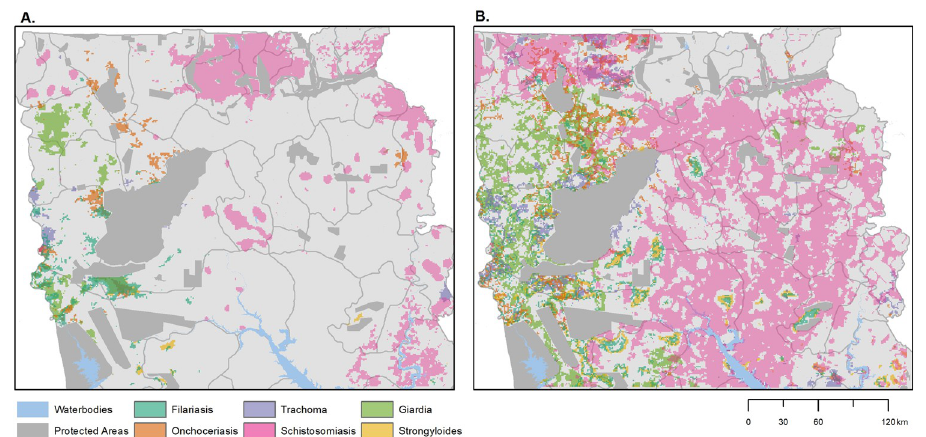
Fig 3. Combining disease measures to A) identify regions with high probabilities of exceeding 10% seroprevalence (exceedance probabilities > 70%); and B) identify regions with high uncertainty (exceedance probabilities 40–60%); administrative shapefiles obtained from National Information Technology Agency (NITA), Government of Ghana (https://data.gov.gh/dataset/shapefiles-all-districts-ghana-170-districts).